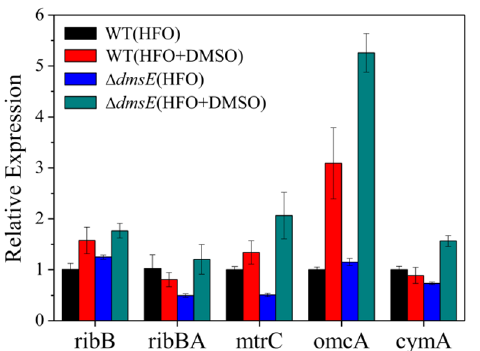
Figure 4. Expression of cymA,mtrC,omcA,ribB,ribBA at 6-h in HFO reduction by WT and D dmsE with or without 20 mM DMSO. The error bars indicate the standard deviation.